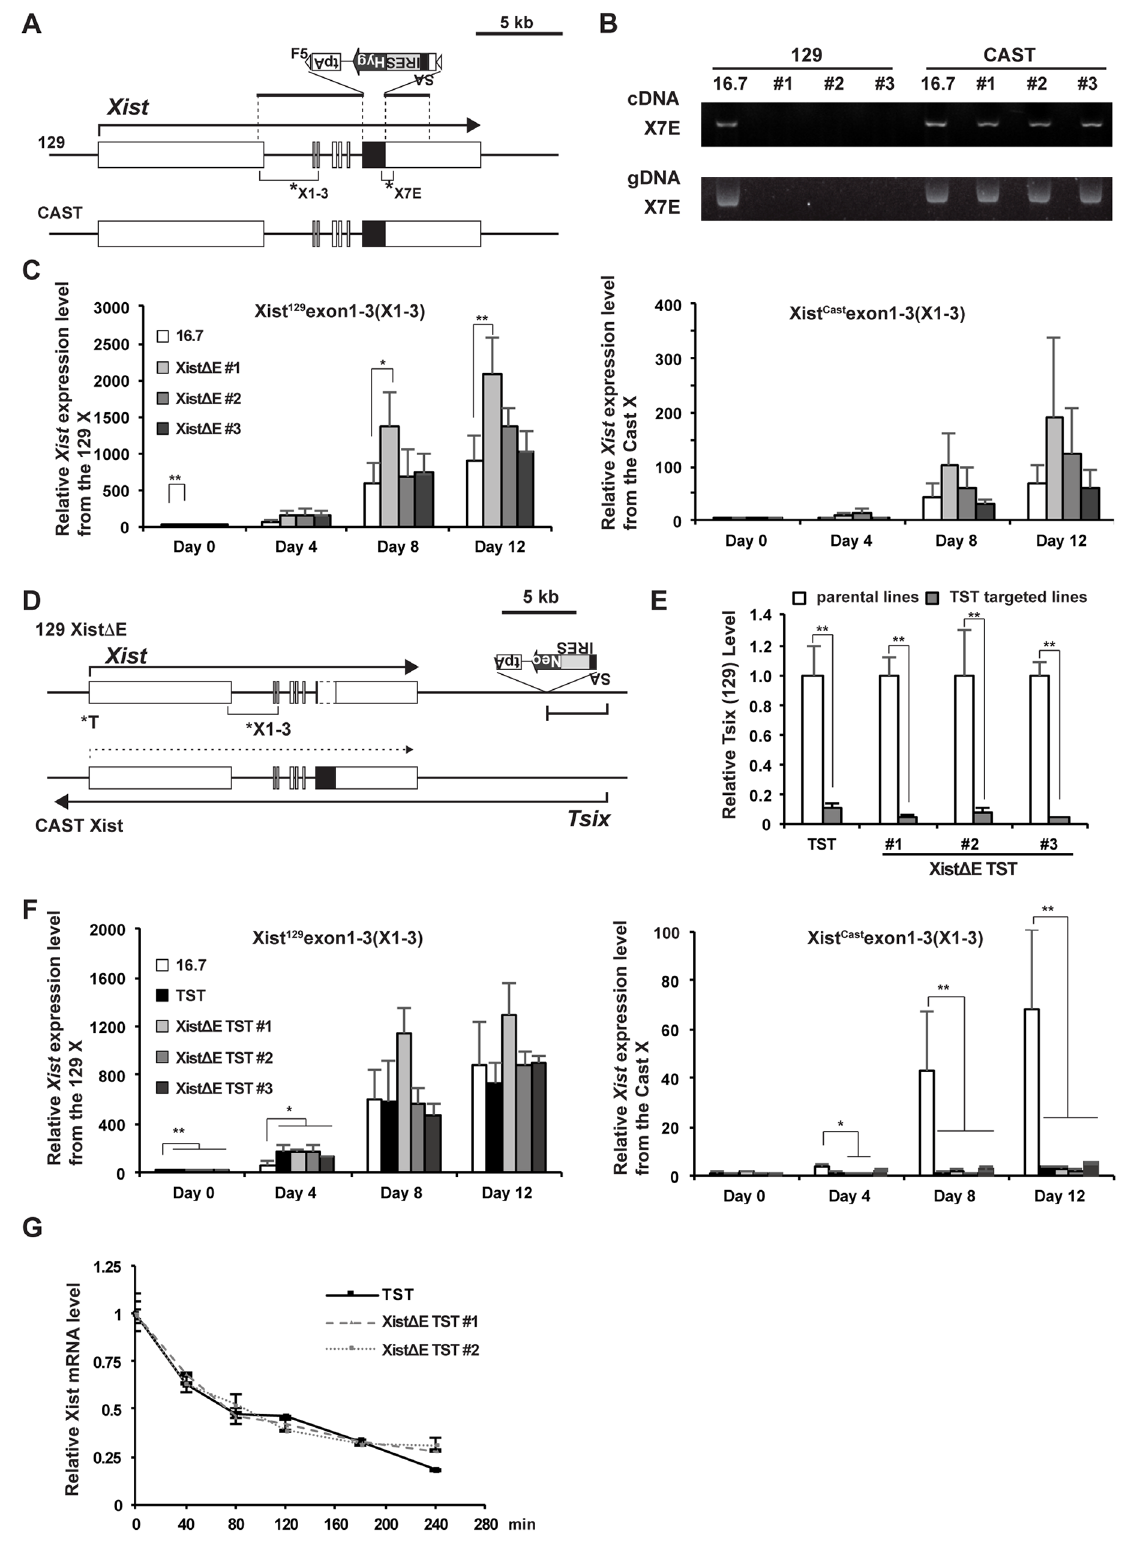
Fig 2. Xist induction occurs normally in the Xist repeat E mutant female ES cells upon differentiation. (A) A map of Xist / Tsix locus to show the targeted deletionof the Xist repeat E (Xist Δ repE) on 129 allele. The targeting vector is shown abovethe